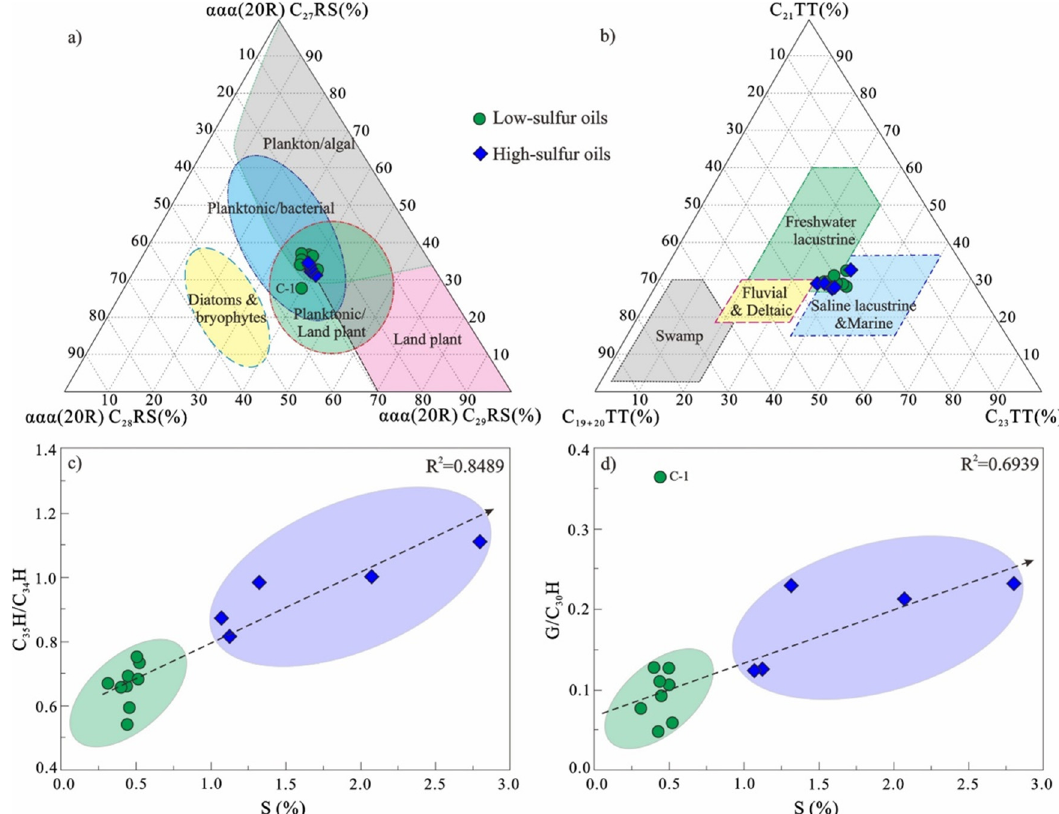
Figure 6. Diagrams showing the origin of the oil samples. ( a ) Triangle diagram of ααα (20R) C 27 , ‐ C 28 , ‐ C 29 regular sterane (Huang and Meinschein, 1979); ( b ) Triangle diagram of C 19 + C 20 , C 21 , and C 23 TT (Xiao et al., 2019); ( c ) Cross plot of sulfur content versus C 35 H/C 34 H. ( d ) Cross plot of sulfur content versus G/C 30 H. sulfur content versus G/C 30